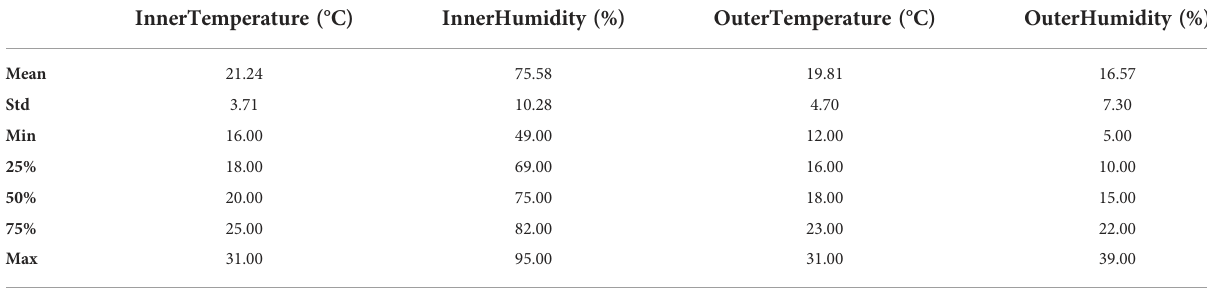
TABLE 3 Statistical analysis of temperature and